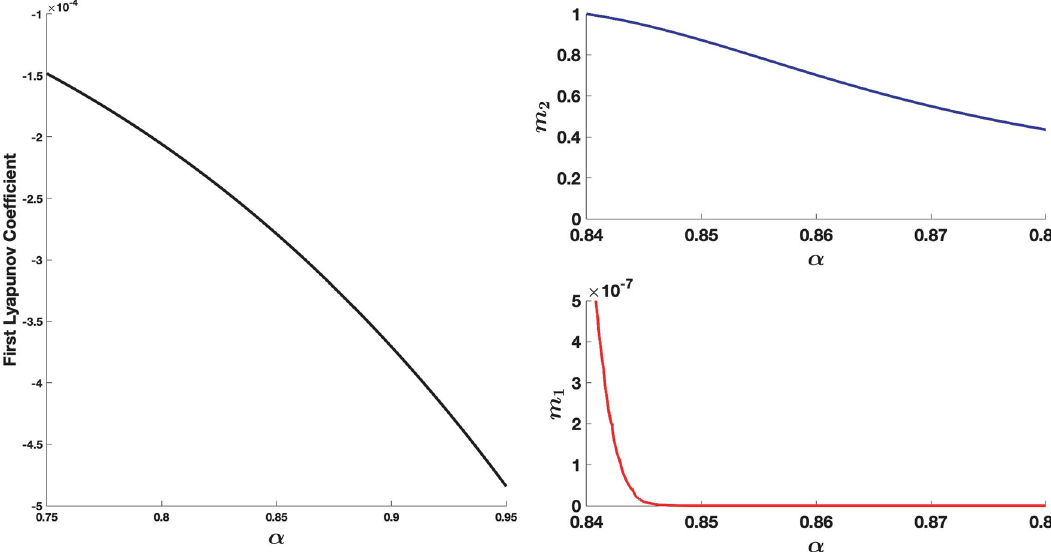
Figure 10. Left panel: Variation of the first Lyapunov coefficient along the Hopf bifurcation curve. Right panel: Variation of the Floquet multipliers associated to the periodic orbits emerging at α = 0.84 when β =